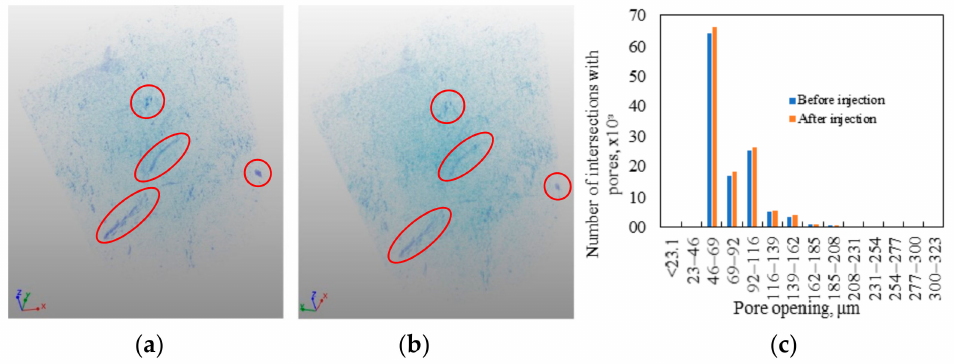
Figure 7. Voids in the IEKEV2517 sample, ( a ) before coreflooding; ( b ) after coreflooding. Red circles mark large voids that have undergone the greatest change after fluid injection. Shades of blue show cracks, matrix not shown; ( c ) pore opening distribution histogram before and after